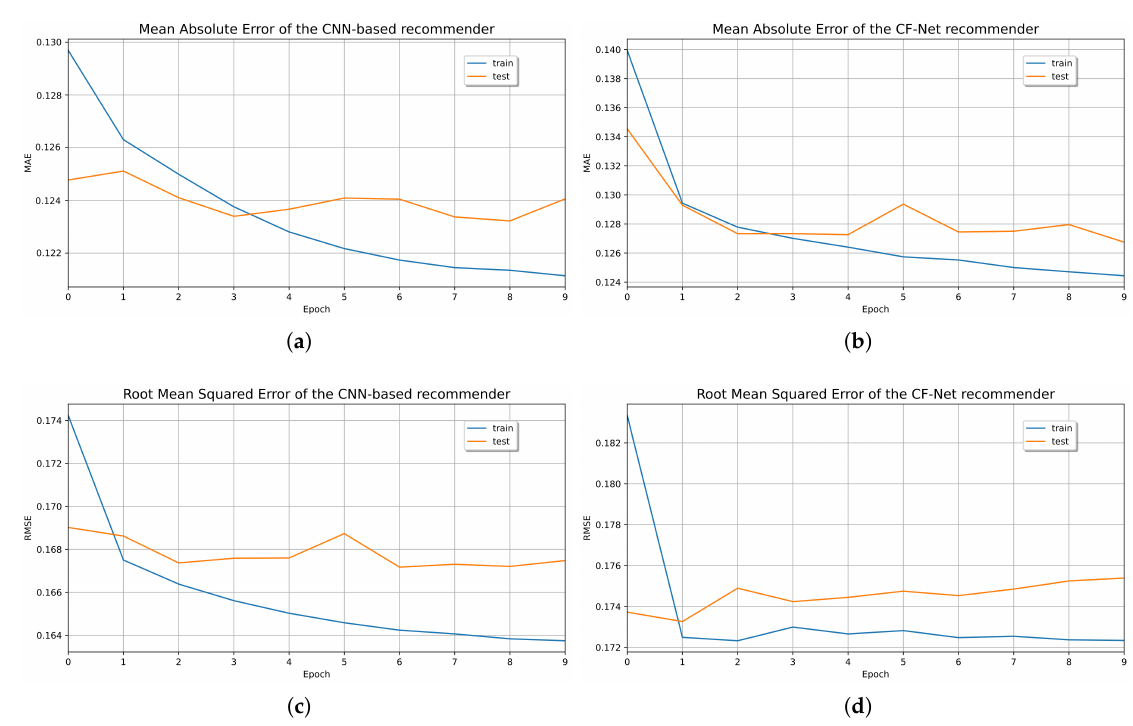
Figure 13. Recommender system evaluation over ( a ) MAE of CF-CNN model; ( b ) MAE of CF-Net model; ( c ) RMSE of CF-CNN model; ( d ) RMSE of CF-Net model.